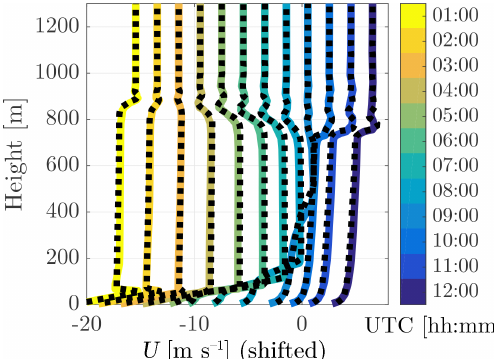
Figure 7. Vertical profiles of the wind-speed magnitude U obtained with the adaptive-grid (in colour) and the fixed equidistant-grid (dashed) SCMs. The 12 plotted profiles are obtained for 24 October with an hourly interval, starting from 01:00 local time. Note that the profiles are shifted in order to distinguish between the different times (with vanishing wind at the surface). The profiles of U are constant with height for z >